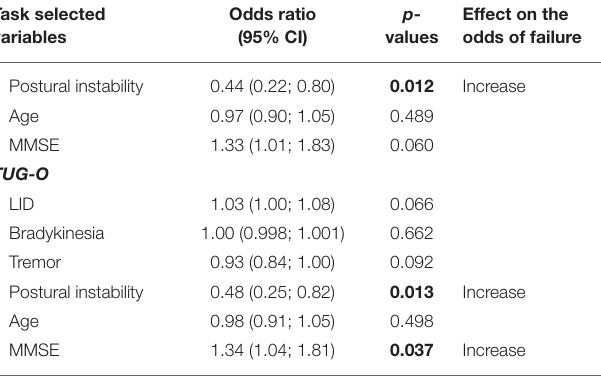
TABLE 2 | Results of binary logistic regressions. Task selected